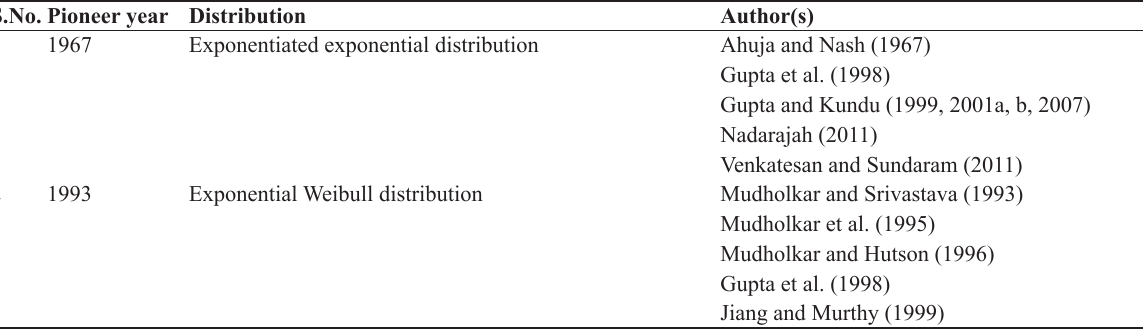
Contributed work on the EF of